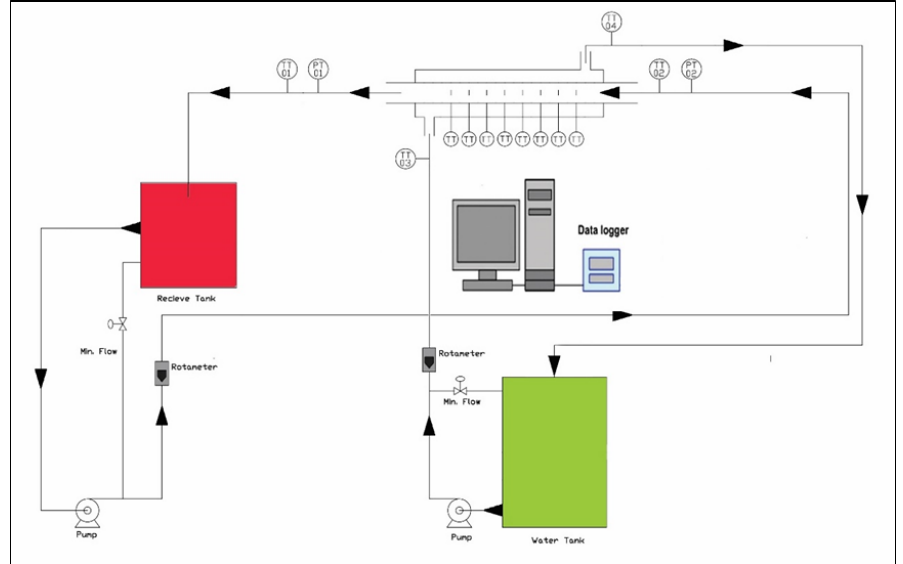
Figure 1. Experimental